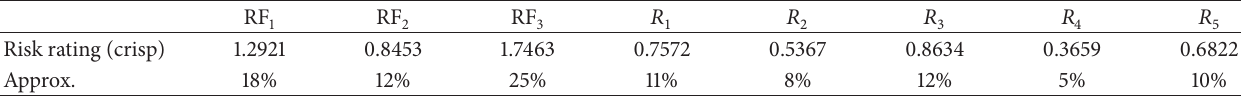
Table 5: The crisp ratings for risk factors and